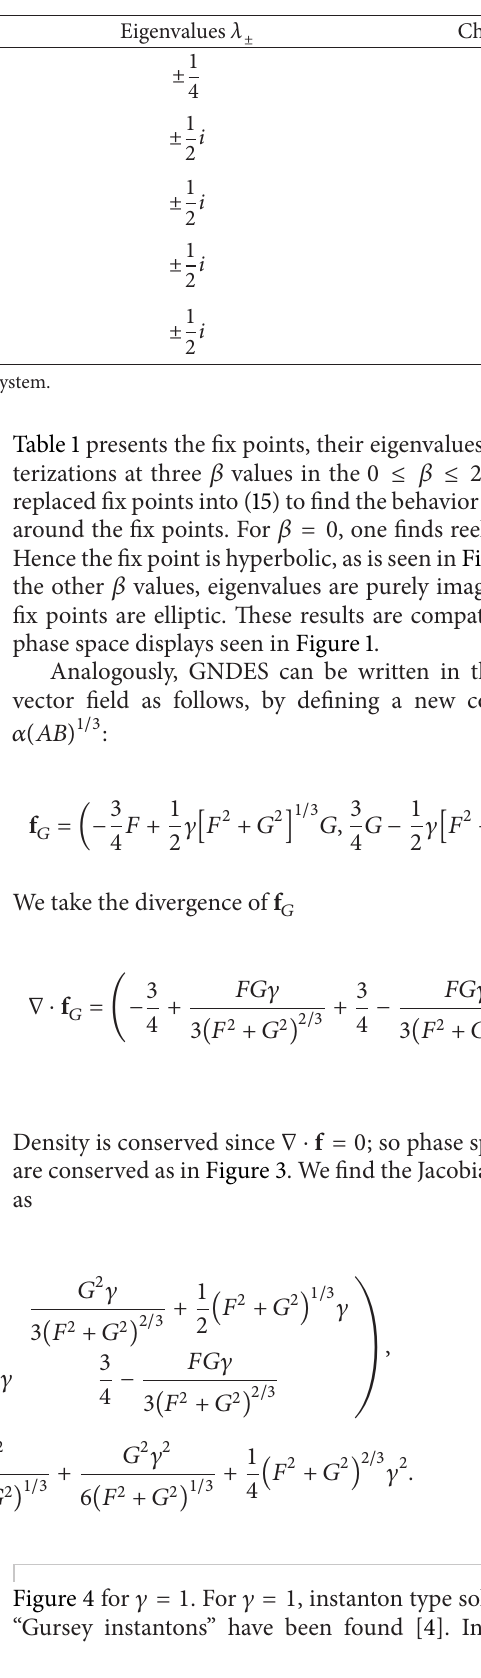
Table 1: Characterization of the fix points.